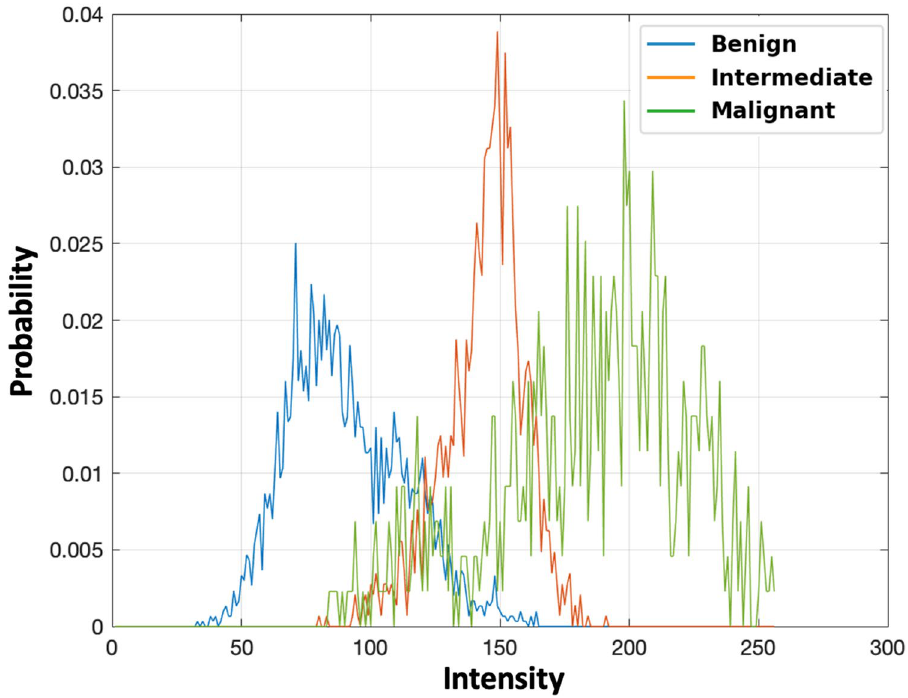
Figure 6. Probability density function visualization of the normalized gray-level intensity histogram for three different liver tumors: benign (blue), intermediate (orange), and malignant (green).